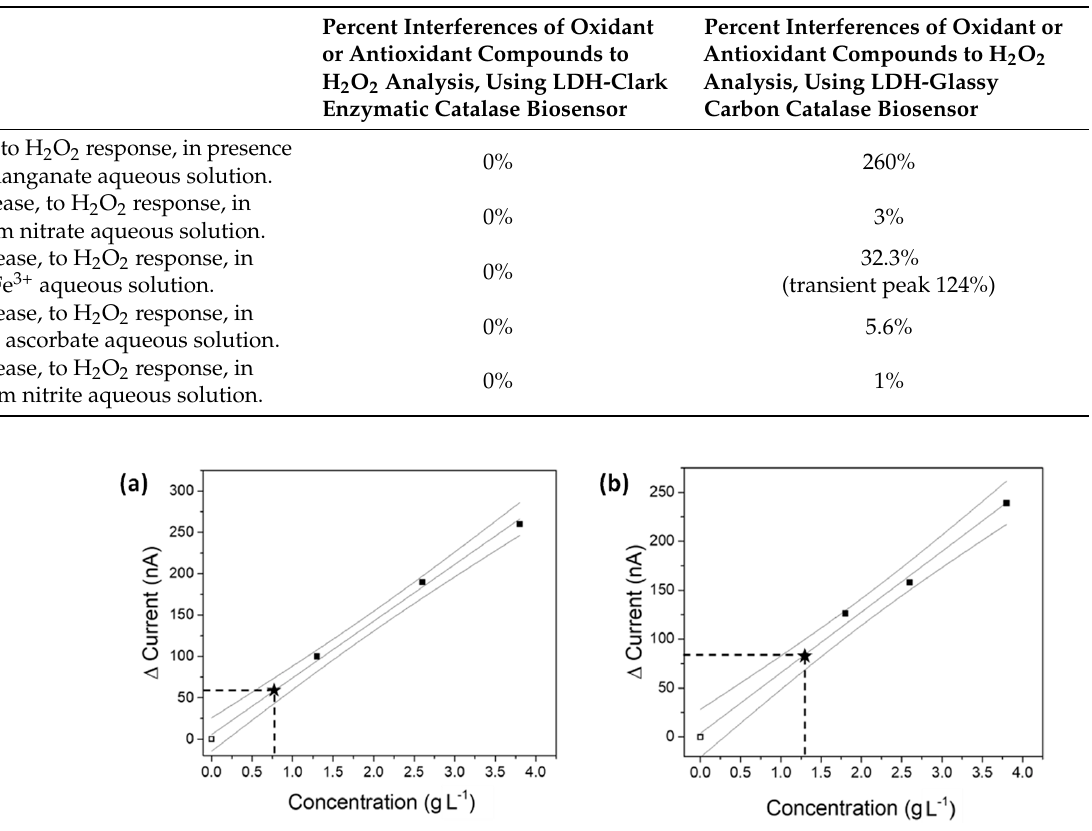
Figure 6. ( a ) Measurement of H 2 O 2 concentration in LB1 cosmetic sample. The experimental calibration curve in matrix and the extrapolated hydrogen peroxide concentration ( ★ ), equal to 0.78 ± 0.05 g L − 1 , are shown. Each point represents the mean of at least three repeated determinations. ( b ) Measurement of H 2 O 2 concentration in LB2 cosmetic sample. The experimental calibration curve in matrix and the extrapolated hydrogen peroxide concentration ( ★ ), equal to 1.30 ± 0.05 g L − 1 , are shown. Each point represents the mean of at least three repeated determinations.